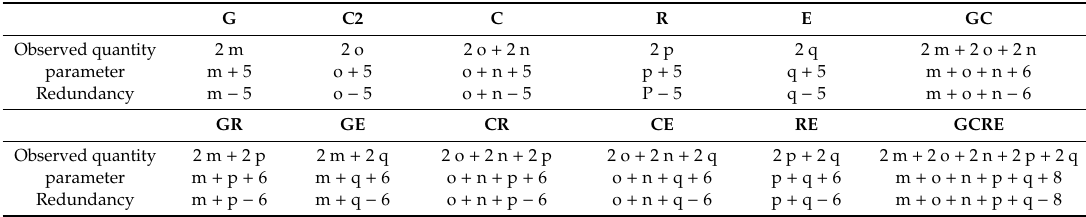
Table 2. Comparison of GPS, BeiDou navigation satellite system (BDS)-2, BDS-2 / BDS-3, GLONASS, Galileo, and multi-Global Navigation Satellite System (GNSS) PPP